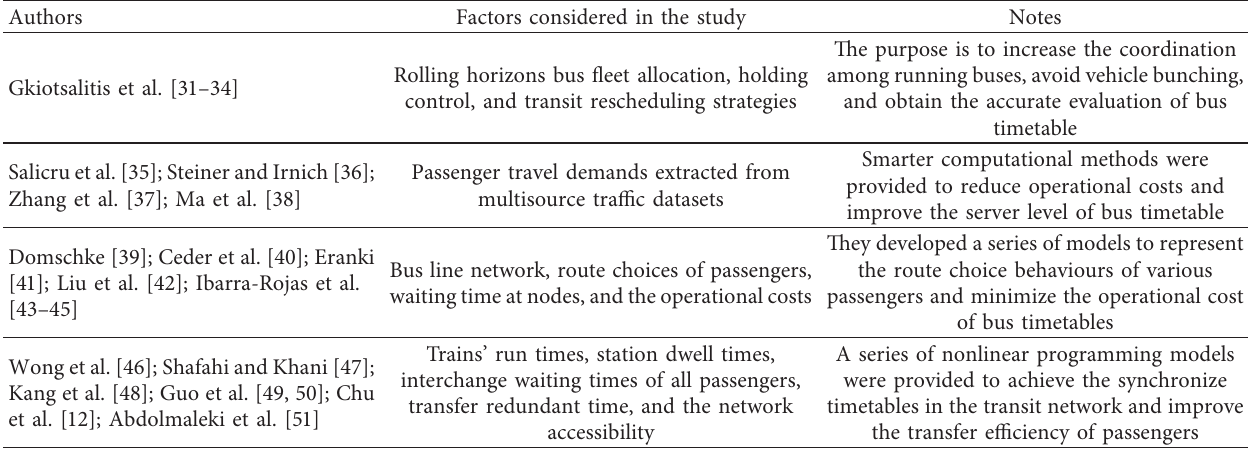
Table 1: Recent research on the scheduling of bus